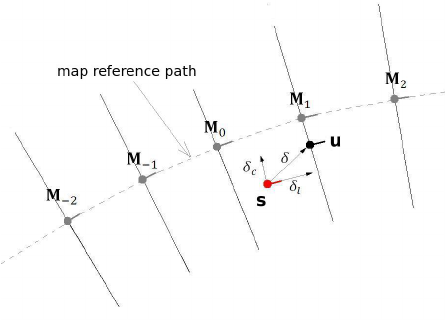
Figure 27. Domain of pose measurements: the black lines are the places that a measurement u can occur and s is the current vehicle’s